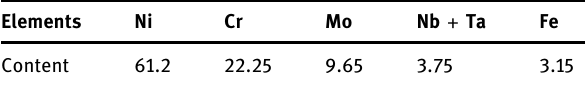
Table 2: Main chemical composition of Inconel 625 alloy ( wt% )